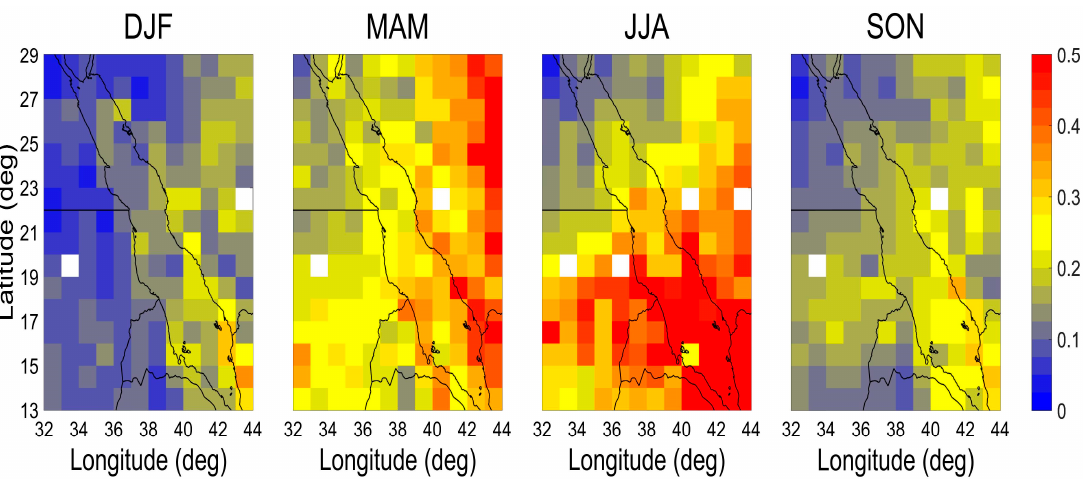
Figure 8. Geographical distribution of the mean Cloud-Aerosol Lidar and Infrared Pathfinder Satellite Observations (CALIPSO) Dust AOD at 532 nm, for the three-month averages: December to February (DJF), from March to May (MAM), from June to August (JJA), and from September to November (SON), for the period 01/2007–12/2015.